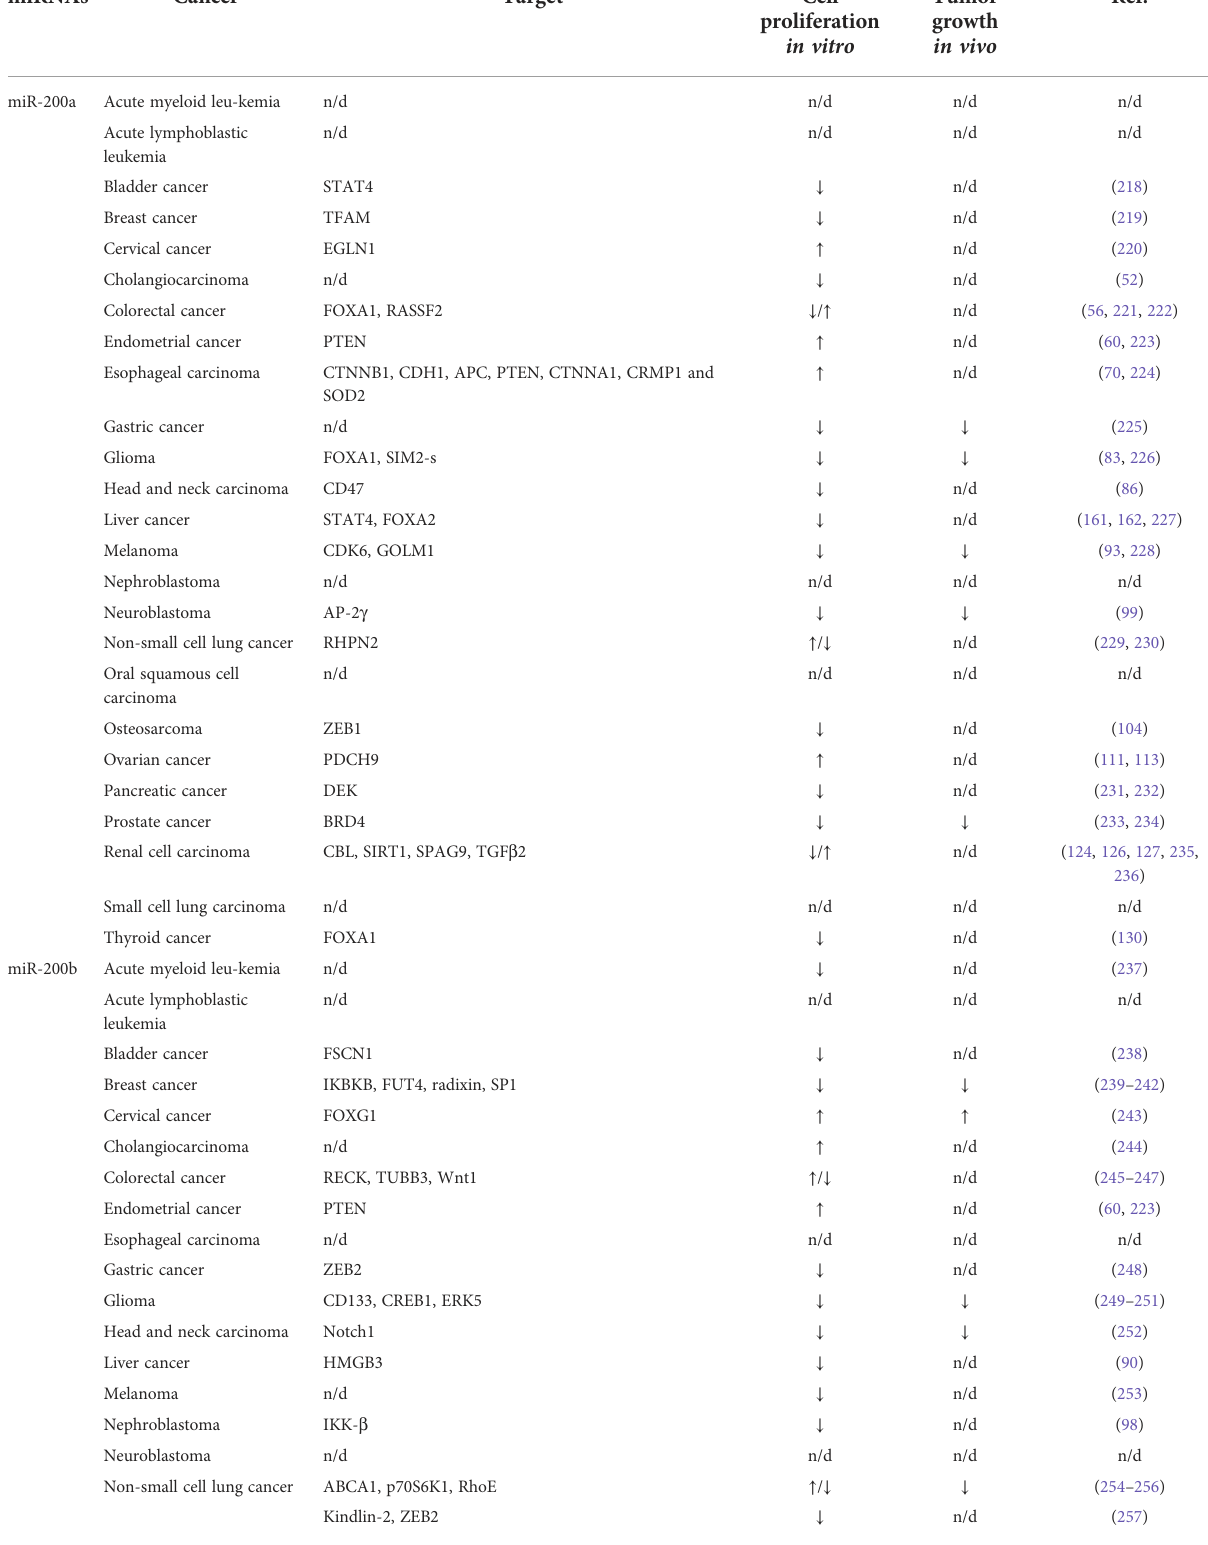
TABLE 3 The role of the miR-200 family in proliferation and tumor growth. miRNAs Cancer Target Cell